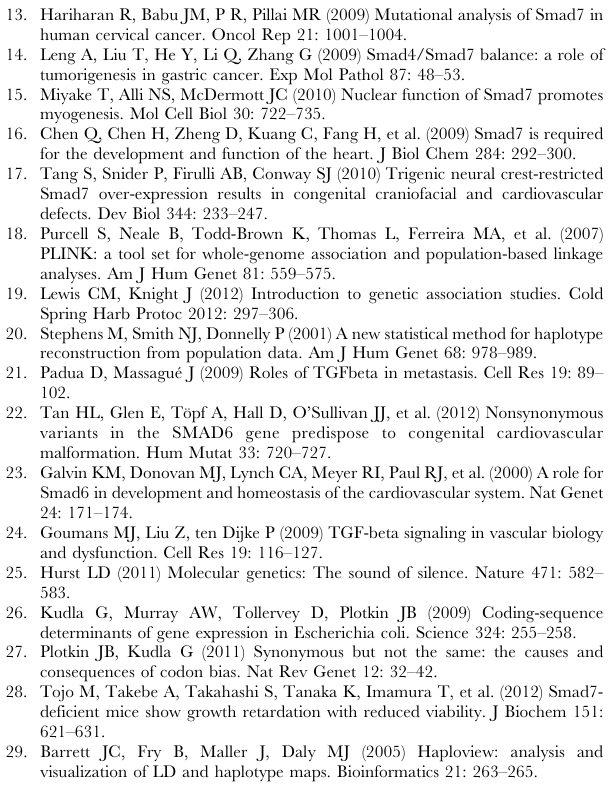
Figure S1 Sequence alignment of SMAD7 non-synony- mous mutations identified in this study. (TIF)